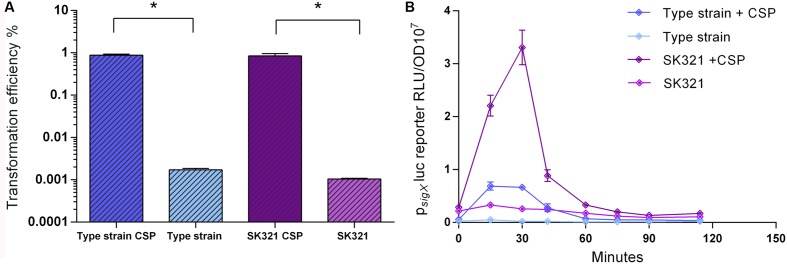
Comparison of transformation efficiency and sigX expression in S. mitis type strain and S. mitis strain SK321. (A)
S. mitis type strain and SK321 pre-cultures at OD600 0.5 were diluted 1:100 in C+YY B and grown until OD600 0.04 at 37°C in 5% CO2. Following, 200 μL aliquots were exposed to 300 nM of their respective strain specific CSP or kept untreated. Cells were transformed with 1 μg mL-1 replicative plasmid pVA838 at 37°C in air atmosphere for 3 h. The % of CFU containing ErmR transformants was determined by plating on blood plates with and without Erm. The results are representative of three independent experiments. Bars represent standard error of the mean. Differences in efficiency between cultures with and without CSP were analyzed by Student’s T-test (∗p < 0.05). (B) The sigX reporter type strain (MI055) and SK321 (MI092) were grown in 200 μL of C+YY B in a 96-well plate in air at 37°C with 300 nM of their respective strain specific CSP or kept untreated. Culture optical density (OD600) and sigX expression (RLU/OD) were monitored periodically. The results are averages from three replicates and representative of three independent experiments. Error bars represent standard error of the mean.